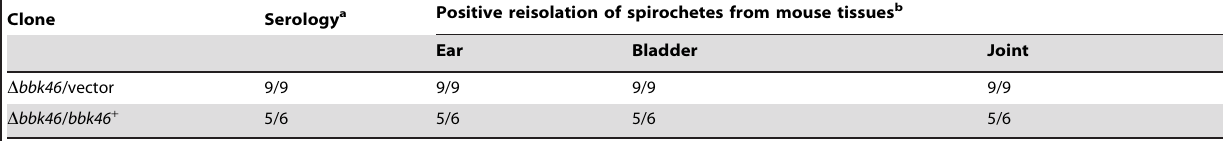
Table 4. The bbk46 gene is dispensable for B. burgdorferi mouse infection by needle inoculation.